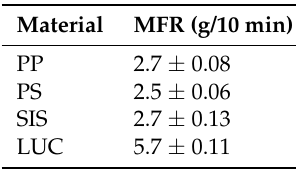
Table 2. Melt flow rate (MFR) values of virgin materials measured at 230 ◦ C/2.16 kg.